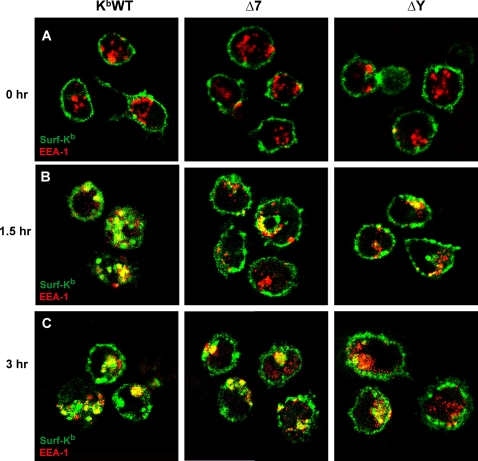
MHC-I cell surface-to-endosome trafficking in DCs is differentially abrogated by mutations in cytoplasmic tyrosine or exon 7-encoded determinants.(A to C) Splenic DCs isolated from KbWT, and Δ7 and ΔY transgenic mice were mounted on coverslips, labeled with FITC-conjugated H-2Kb-specific mAb, washed, then incubated at 37°C for the indicated times. DCs were then fixed, permeabilized and counterstained for EEA-1. Images were acquired using a multiphoton fluorescence confocal microscope. Yellow color indicates co-localization of surface-derived H-2Kb (green) with EEA-1 (red). Data are representative of at least 3 images captured from 2 independent experiments.